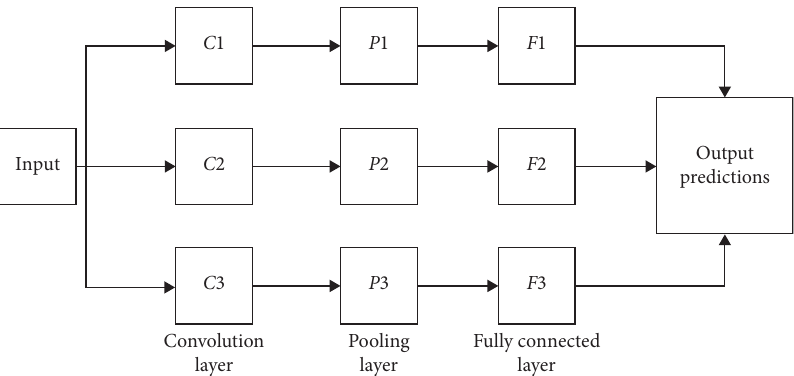
Figure 2: Illustration of the structure of the CNN model.